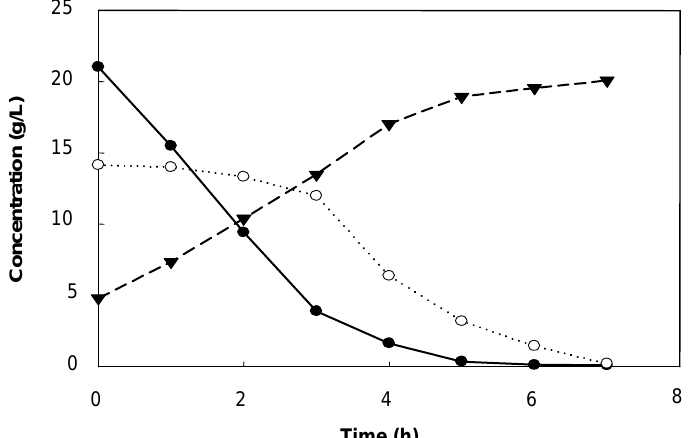
Figure 3. Profiles of glucose ( ● ), fructose ( ○ ) and ethanol ( ▼ ) in cultivation of orange peel hydrolyzate by encapsulated S. cerevisiae